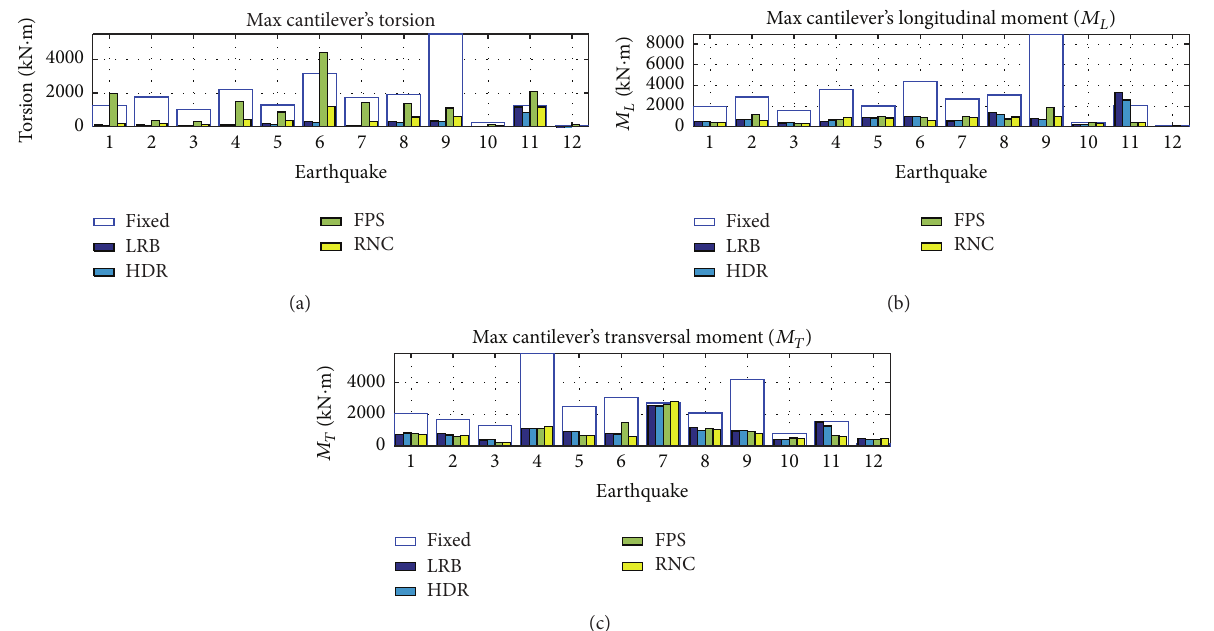
Figure 9: The pier’s cantilever peak moments: (a) torsion; (b) longitudinal moment; (c) transversal moment.